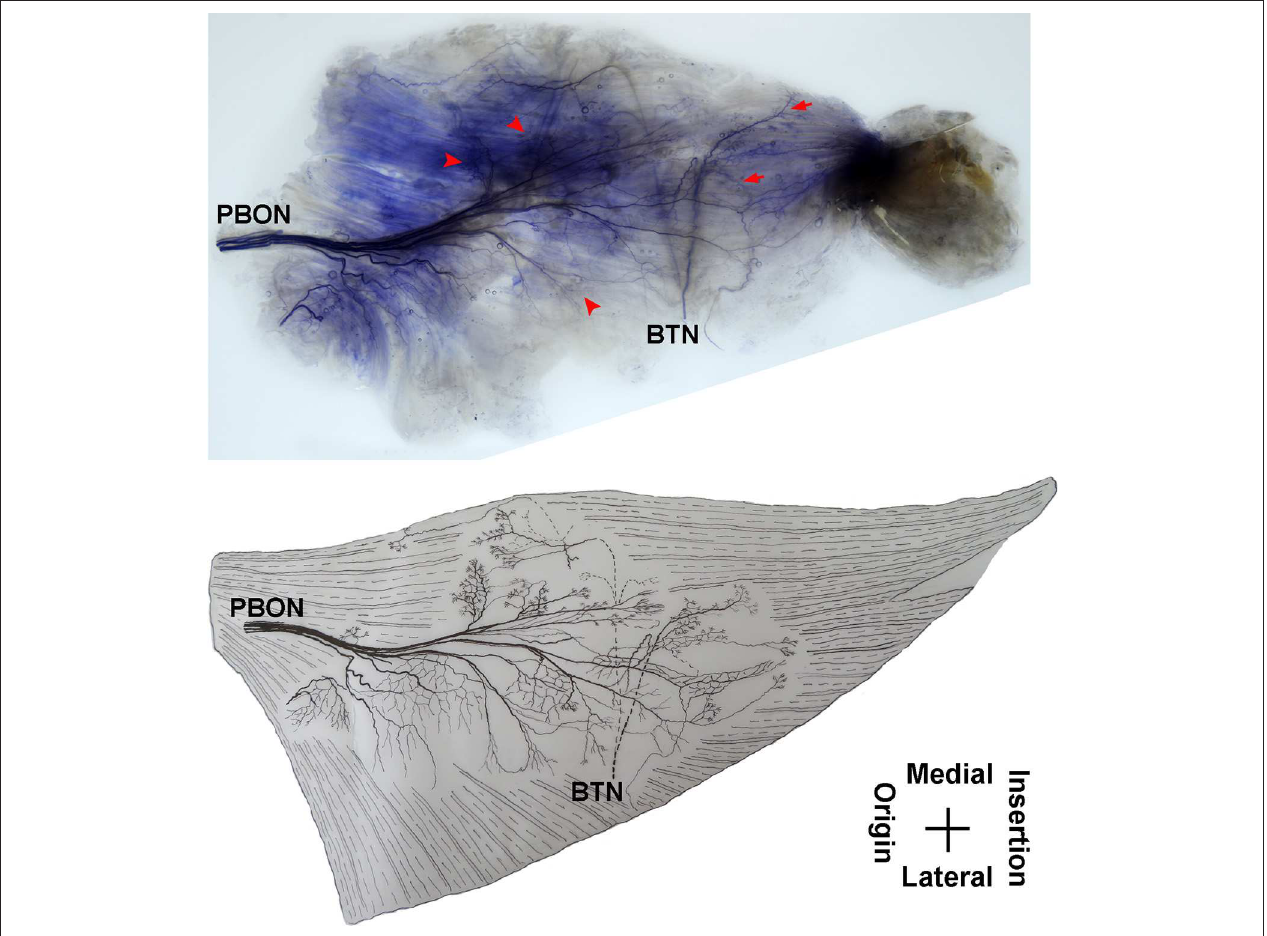
FIGURE 5 | Distribution of intramuscular nerves in the adductor magnus (right, superficial side). The arrow indicates the O-shaped and Y-shaped terminal nerve junctions, and the arrowhead indicates the claw-like terminal nerve distribution (PBON, posterior branch of the obturator nerve; BTN, branch of the tibial